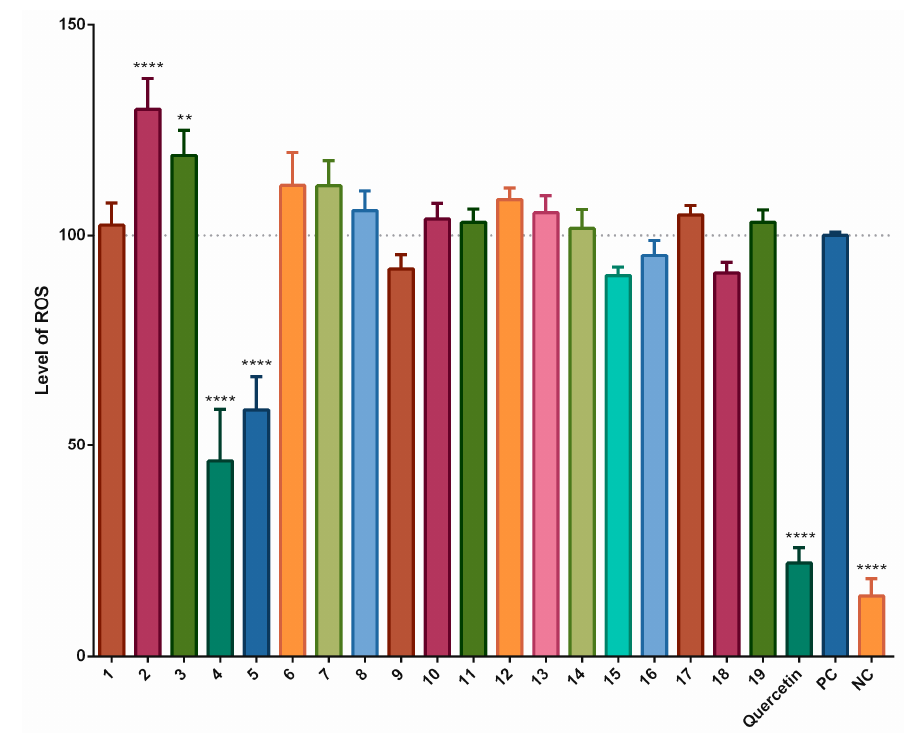
Figure 2. Antioxidant and pro-oxidant e ff ects of stilbenoids 1–19 (at a concentration of 2 µ M) on the formation of ROS after 1 h of incubation. In the THP-1-XBlue-CD14-MD2 cell model, the formation of ROS was triggered by adding 100 µ M pyocyanin; quercetin was used as the standard (2 µ M), pyocyanin alone served as the positive control (PC; 100 µ M) and the vehicle alone was the negative control (NC). ** = p < 0.01; **** = p < 0.0001.